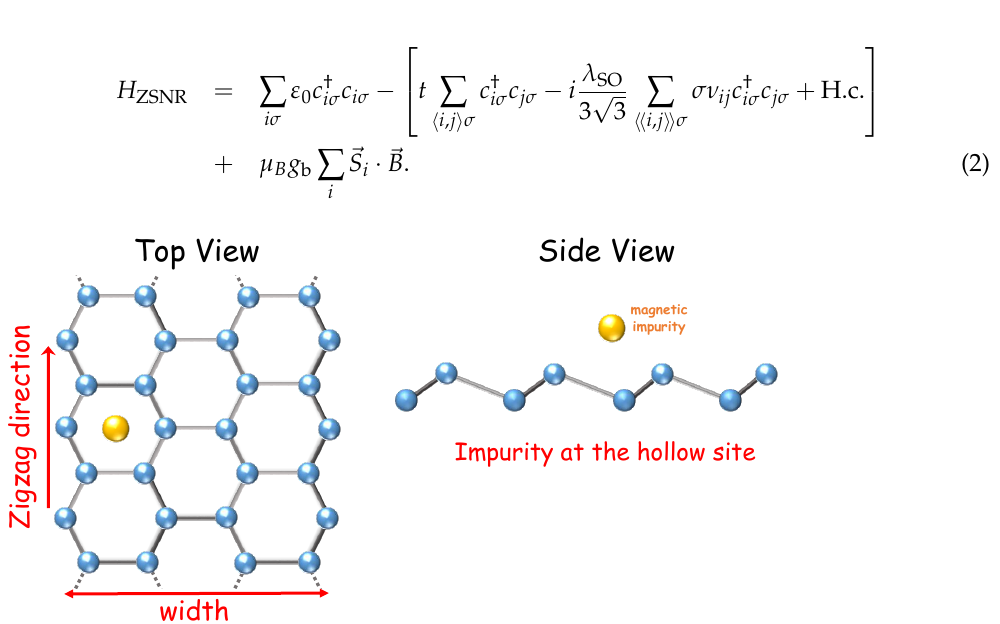
Figure 1. Schematic representation of a ZSNR (top view and side view) with a magnetic impurity located at the so-called hollow